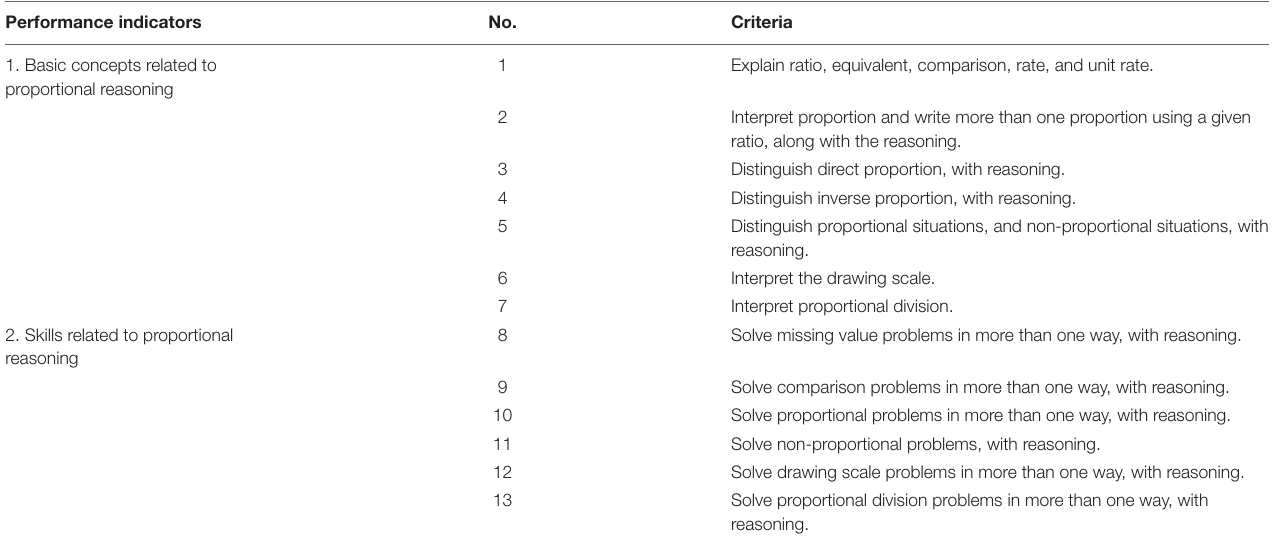
TABLE 1 | Criteria for selecting the tasks of proportional reasoning test. Performance